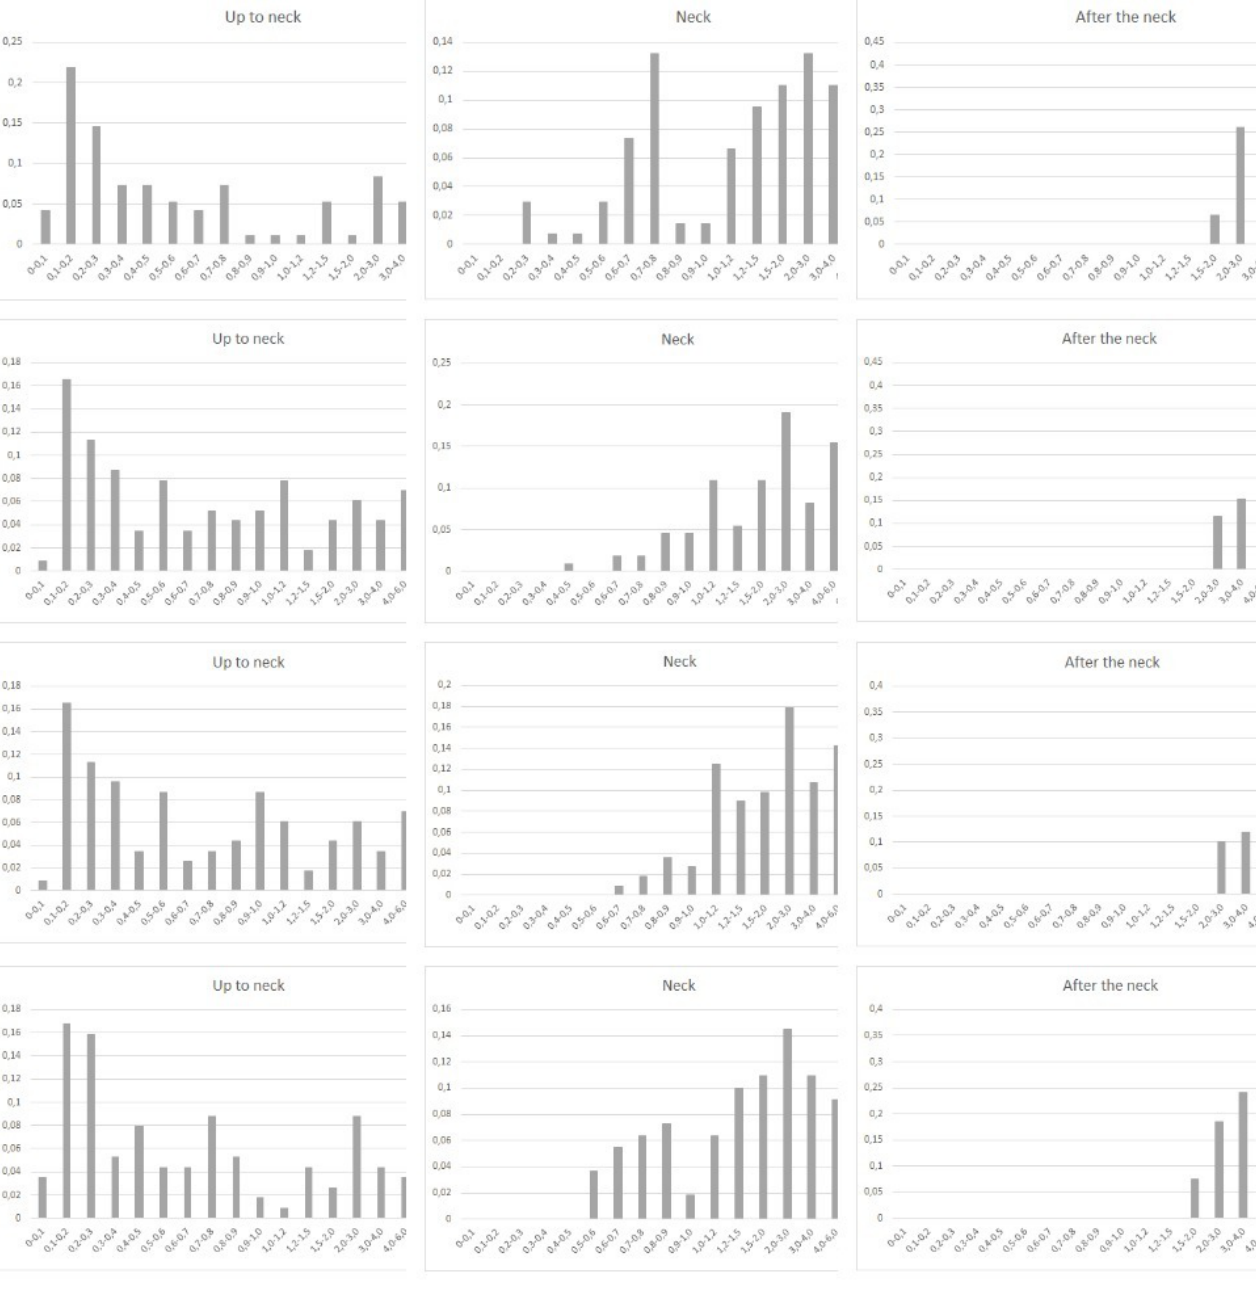
Figure A3. Histograms of ∆ WSS distribution over the stent surface of Patient